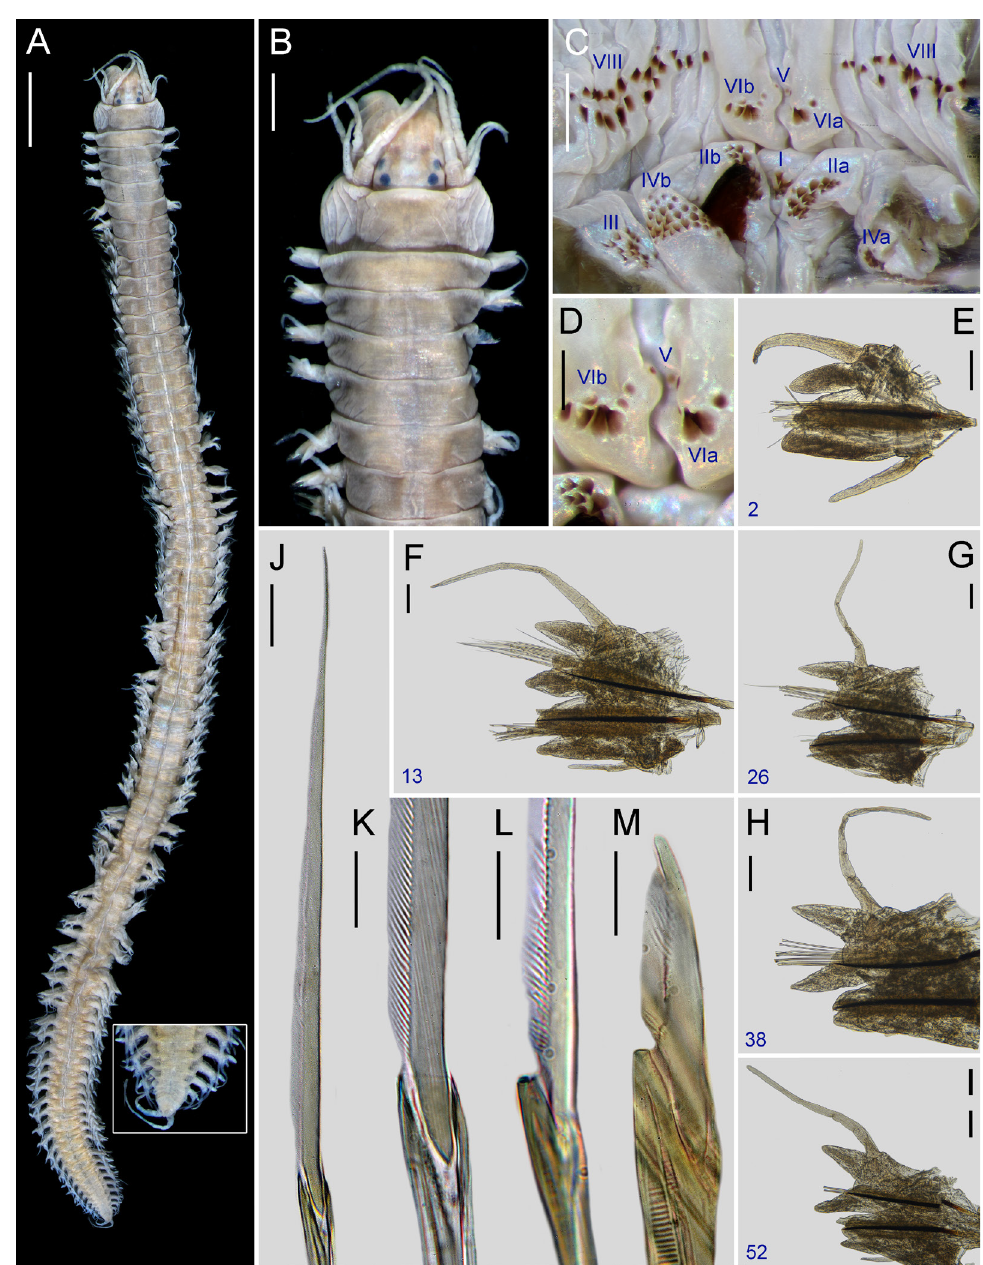
Fig. 1. Neanthes chilkaensis (Southern, 1921). Lectotype (NHMUK 1938.5.7.27) from Chilika Lake, Orissa, India, atokous. A . Entire body in dorsal view (inset: approach of pygidium). B . Anterior end in dorsal view. C . Non-everted pharynx in ventral view. D . Dorsum of oral ring of non-everted pharynx in ventral view. E . Left parapodium from chaetiger 2 in posterior view. F . Left parapodium from chaetiger 13 in posterior view. G . Right parapodium from chaetiger 26 in anterior view. H . Right parapodium from chaetiger 38 in anterior view with ventral cirri contracted and hidden behind the neuroacicular ligule. I . Parapodium from chaetiger 52 in anterior view. J . Homogomph spiniger from notochaetae (chaetiger 13). K . Homogomph spiniger from supracicular neurochaetae (chaetiger 13). L . Heterogomph spiniger from subacicular neurochaetae (chaetiger 2). M . Heterogomph falciger from subacicular neurochaetae (chaetiger 13). Roman numerals refer to the areas and Arabic numbers to chaetigers. Scale bars: A = 3 mm; B = 1 mm; C = 0.5 mm; D–I = 0.2 mm; J–M = 20